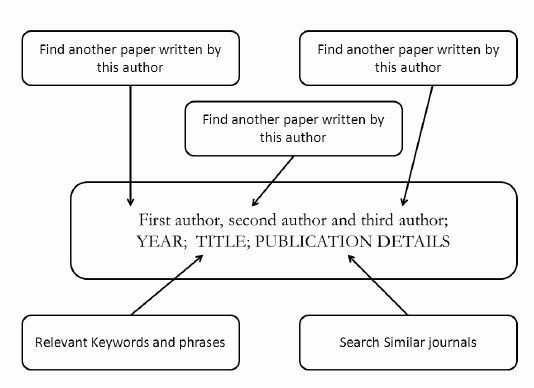
Figure 2. Enhancement of the information literacy resources for the development of the capstone literature